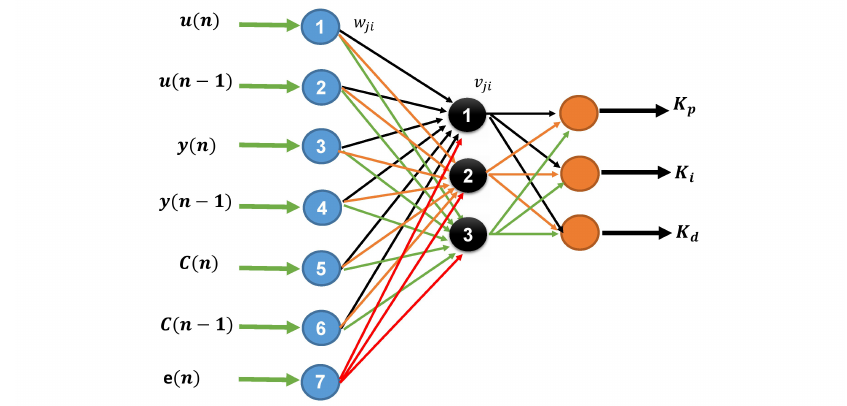
Figure 3. Block diagram of the implemented backpropagation